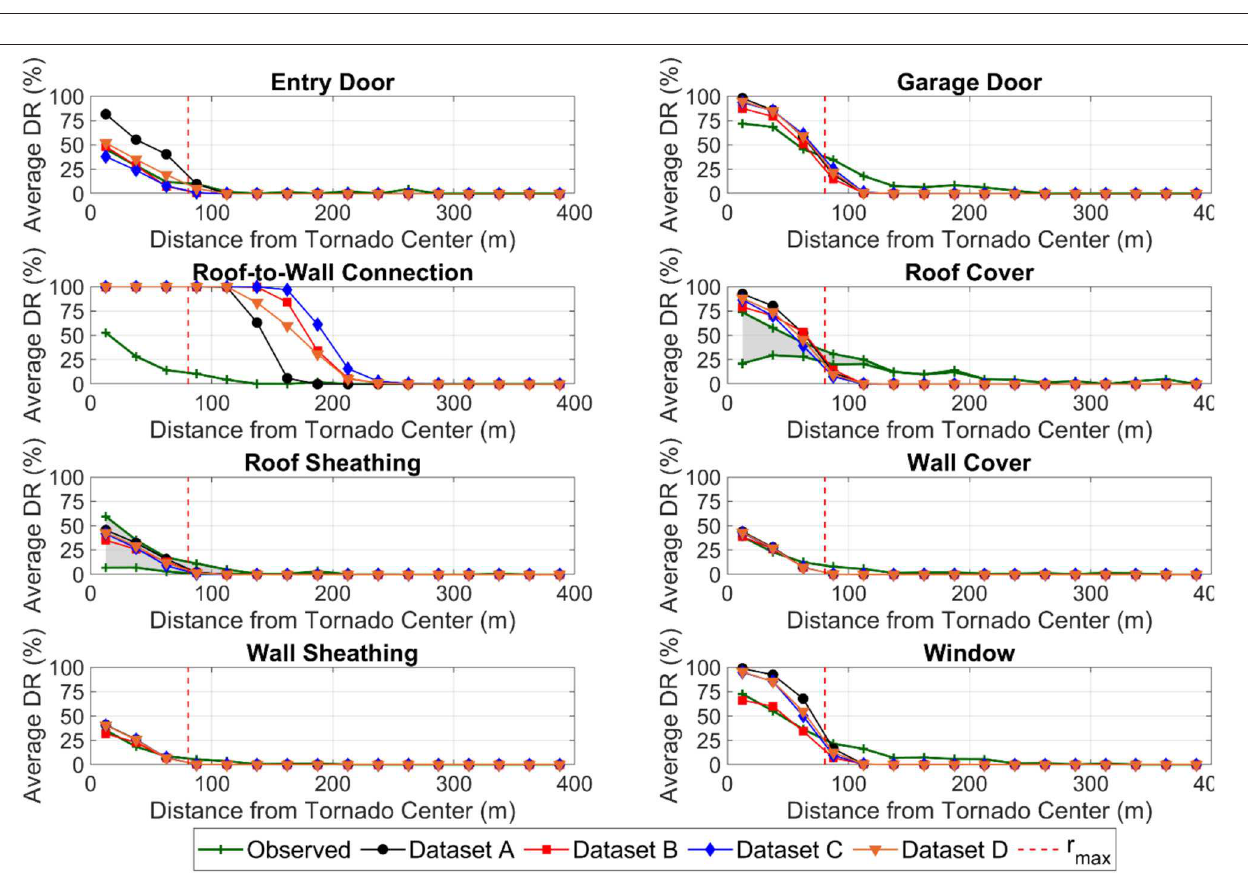
FIGURE 3 | Distribution of 712 Garland/Rowlett houses with binned distance from tornado center. Each value above a bar represents the number of houses present in that bin. Bin size = 25m. The red dashed line indicates the radius to maximum wind speeds (RMW).